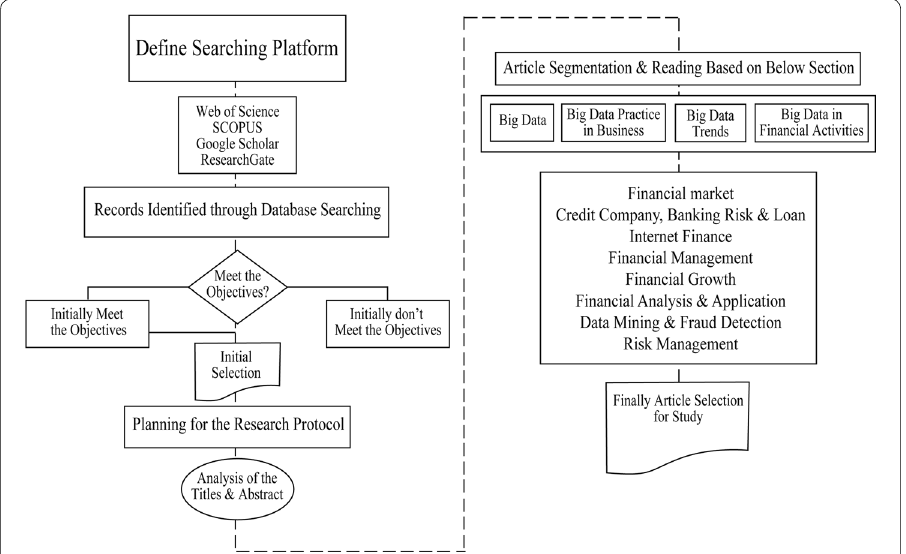
Fig. 1 Systematic framework of the research structure. (Source: Author’s